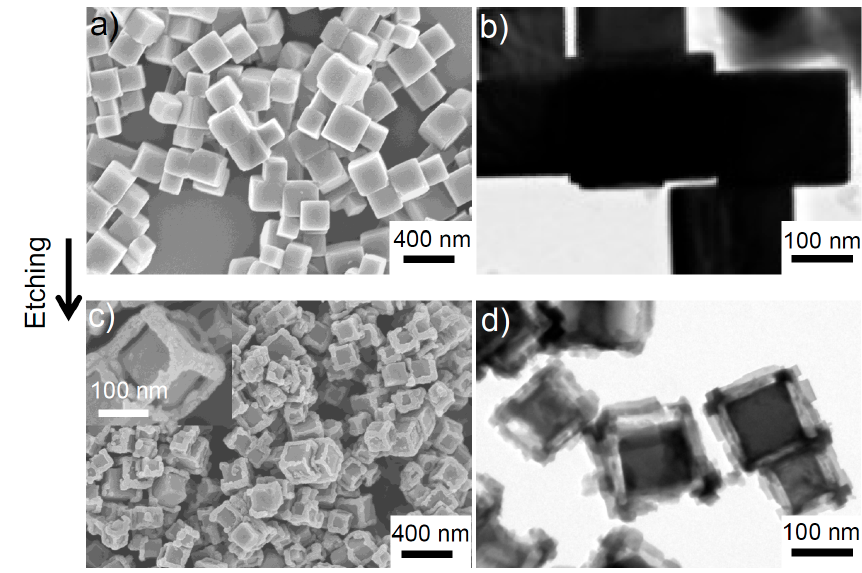
Figure 2. ( a ) SEM image of cubic crystals. ( b ) TEM image of cubic crystals. ( c ) SEM image of the product from etching of the cubic crystals. Inset is an enlarged image of a particle. ( d ) TEM image of the product from etching of the cubic crystals.